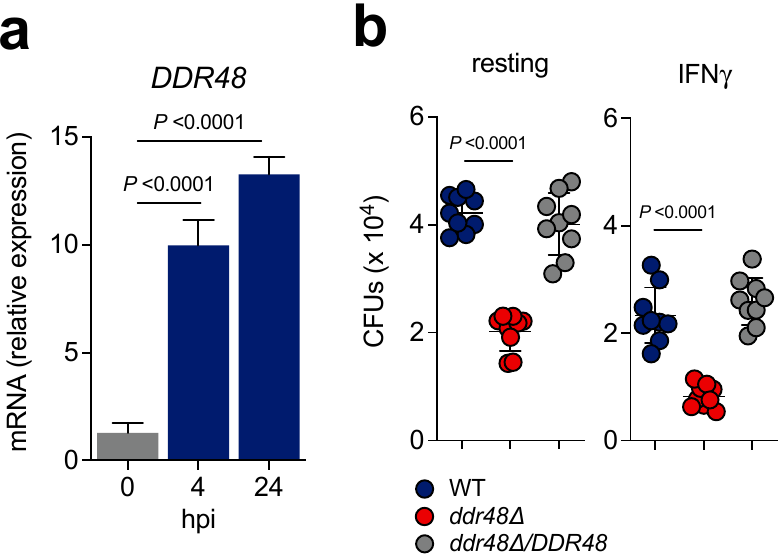
( c ) left untreated (0) or treated with 0.1 µ g/mL amphotericin-B (AMB; polyene) or 0.25 µ g/mL ketoconazole (KTZ; azole) for 15, 30, and 60 min ( n = 9) measured by qRT-PCR relative to HHT1 levels. Expression of genes is presented as normalized row intensity (blue and red tiles) grouped by chronological step in the ergosterol biosynthesis pathway. All data generated were performed on three technical replicates and at least two biological replicates.